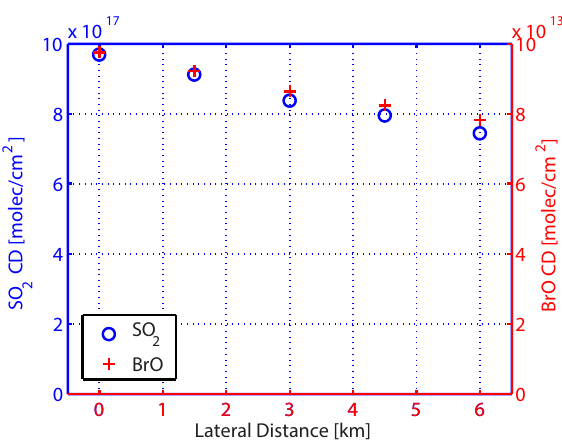
Figure 12. McArtim results for the influence of an increasing lateral distance between instrument and volcanic plume on the SO 2 / BrO ratio. The ratio of the two trace gases is only slightly influenced by an increasing